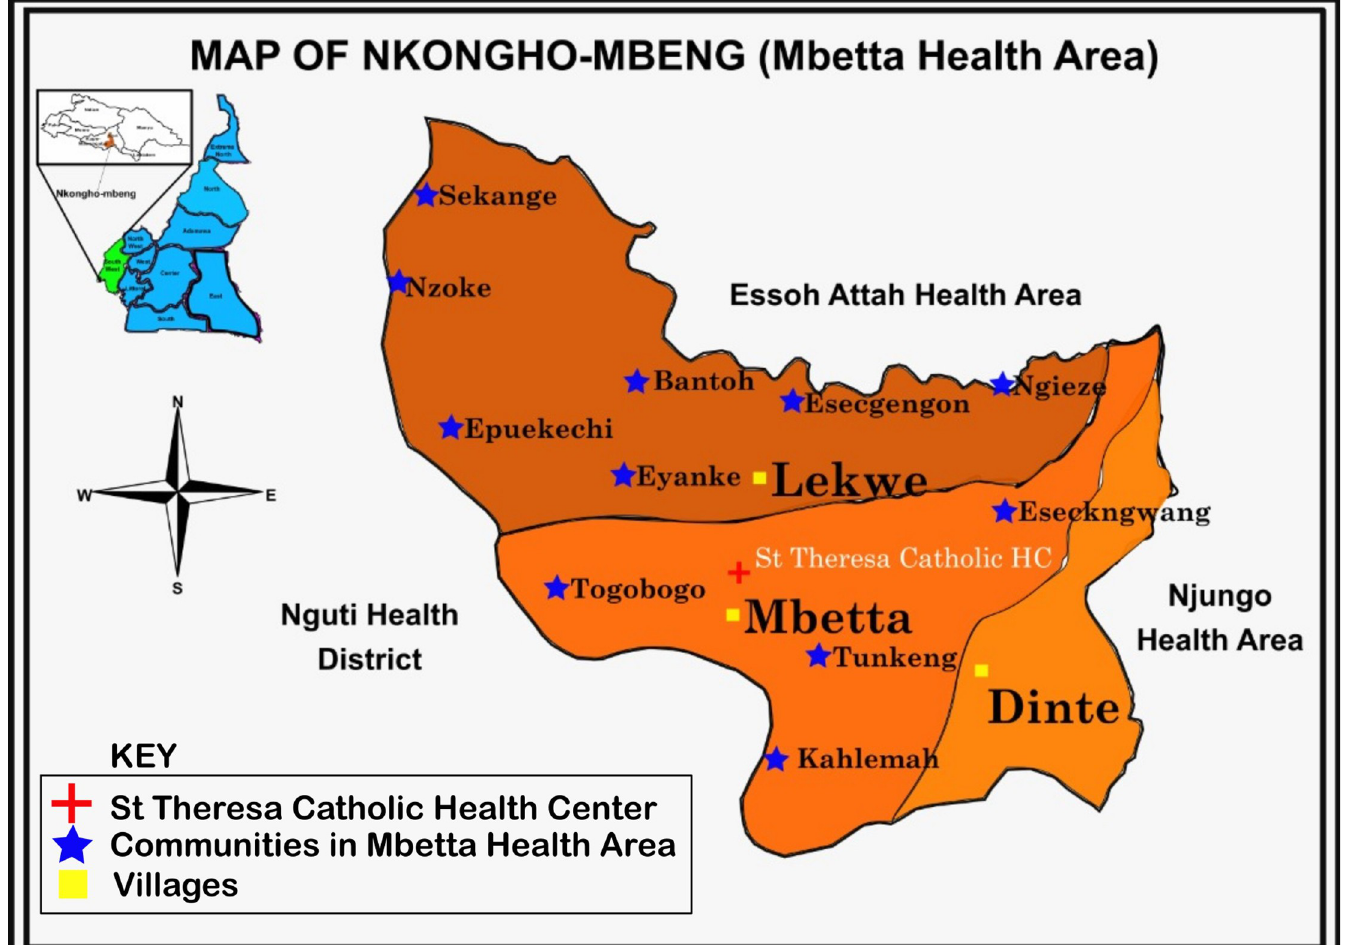
Fig 1. Map of Nkongho-mbeng (Mbetta health area) in the South West Region of